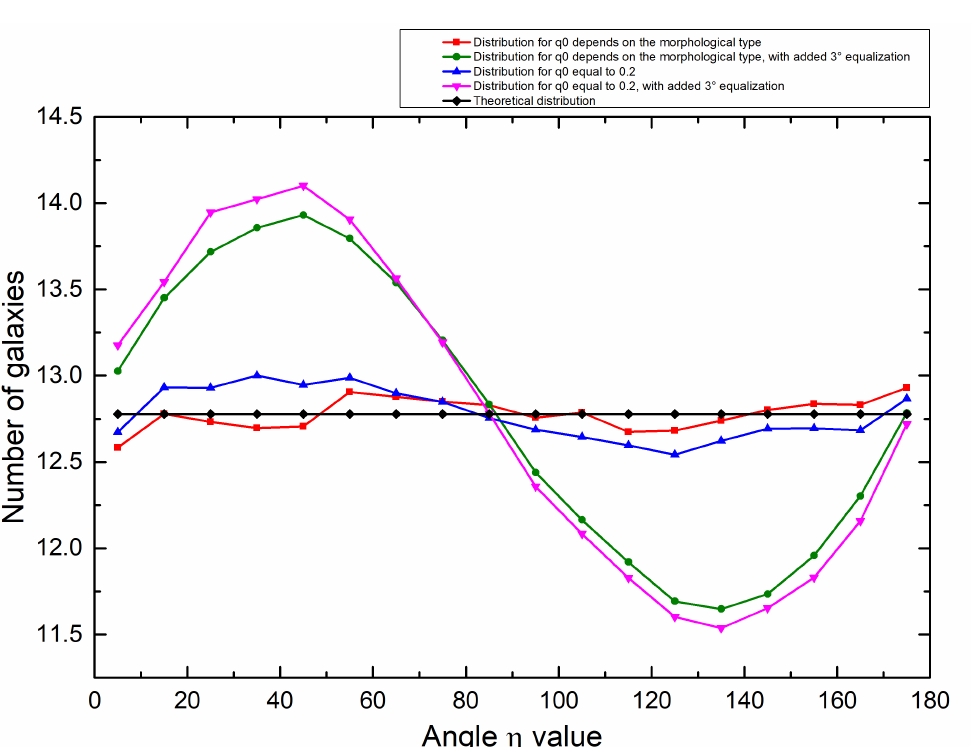
Figure 8. Simulated distributions of the angle η for group